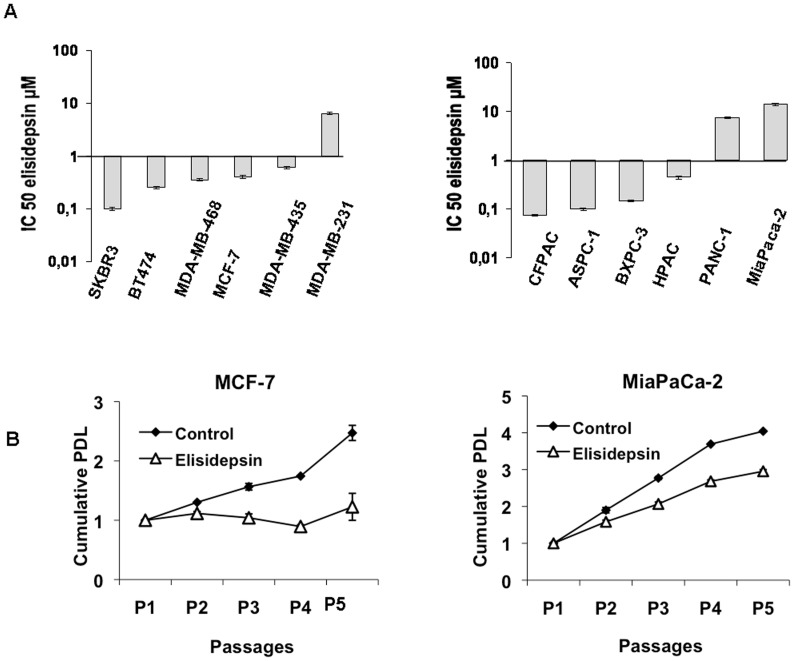
Elisidepsin sensitivity.A) Elisidepsin IC50s were determined in a panel of breast (left) and pancreatic (right) cancer cell lines using a crystal violet assay. Cells were exposed to elisidepsin for 72 h. Results are shown as the mean ± SD of at least three independent experiments. B) Cell proliferation in parental and subtoxic elisidepsin-treated cells. Cumulative numbers of cell divisions [shown as population doubling level (PDL)] are shown for MCF-7 and MiaPaCa-2 cells until passage 5. Proliferation of MCF-7 (IC50∶0.4 µM) and MiaPaCa-2 (IC50∶14 µM) cells was suppressed when elisidepsin was added to the culture at subtoxic doses (0.2 and 1 µM, respectively). The number of MiaPaCa-2 and MCF-7 seeded cells were 1.25×105 and 1.4×105, respectively. Each growth curve was performed at least twice with similar results, SDs are shown, and each time point was performed in duplicate. P, passage.